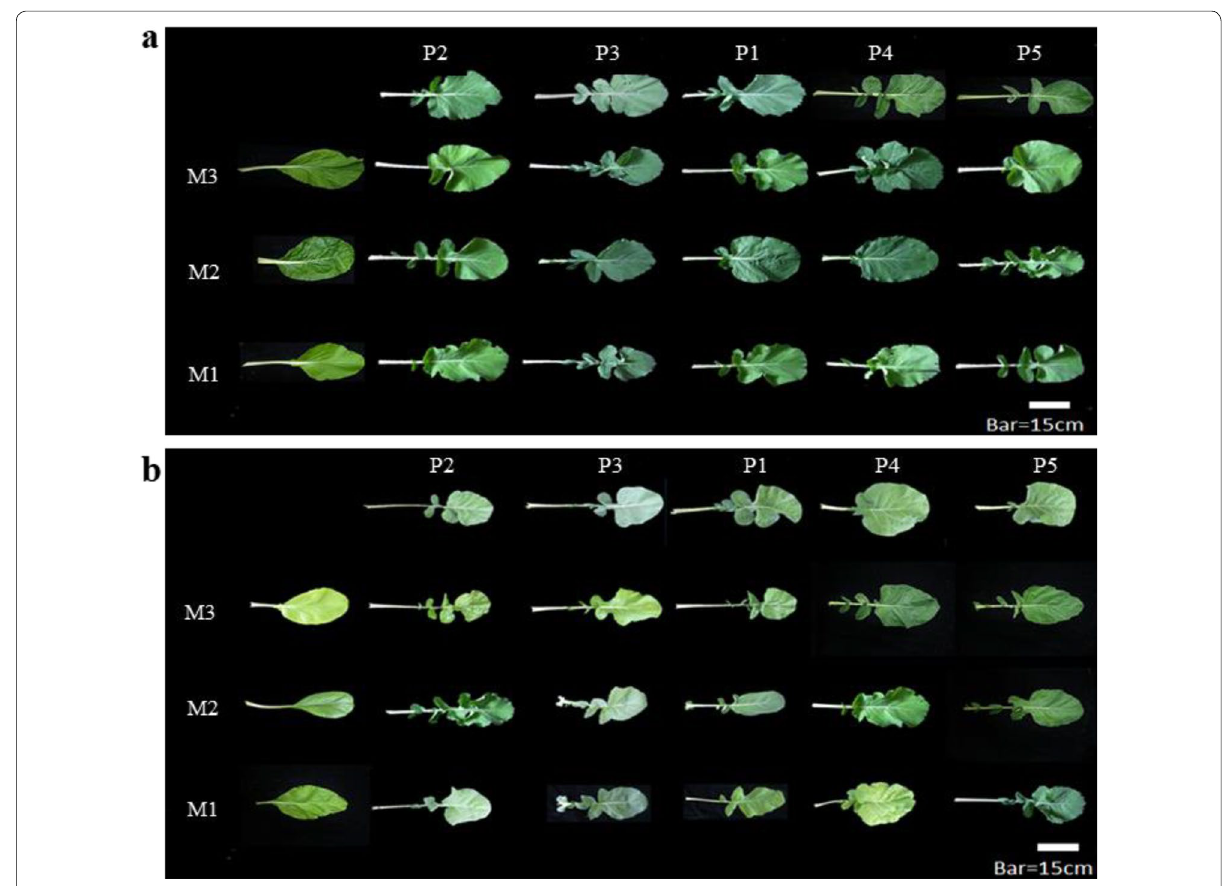
Fig. 2 Morphology examination of rosette leaves for different varieties and the interspecific F 1 hybrids. a In the experiment field. b In the greenhouse. M1: “Nongxing 80 days,” M2: “Wansheng rape,” M3: “Edible rape,” P1: “Deza oil No. 18,” P2: “Gueiza No. 4,” P3: “Zhong oil No. 36,” P4: “Wan oil No. 25,” and P5: “FTHEB